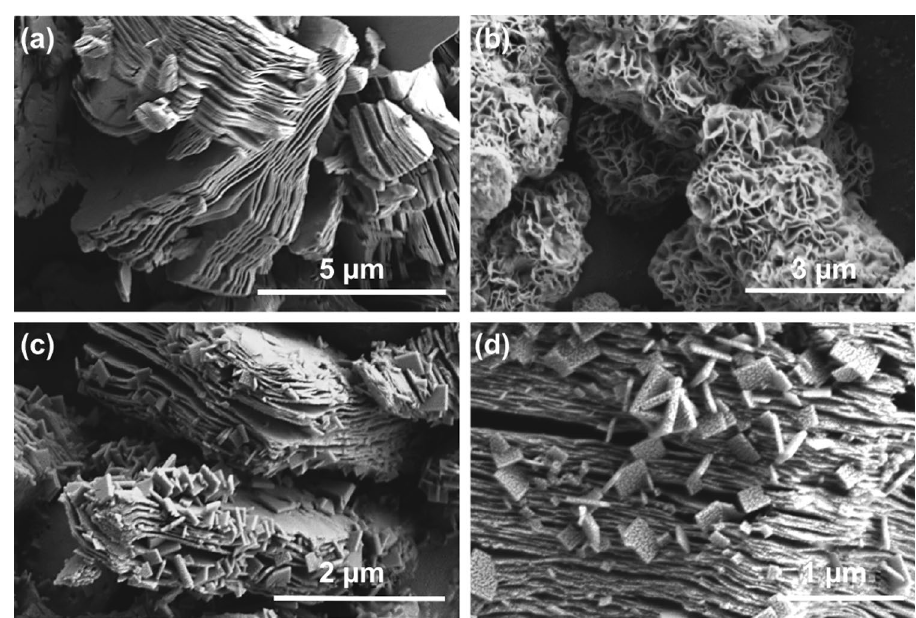
Fig. 2 SEM images of a Ti 3 C 2 MXene, b 1T-WS 2 , and c, d 1T-WS 2 @TiO 2 @Ti 3 C 2 composites (15 wt% WS 2 )